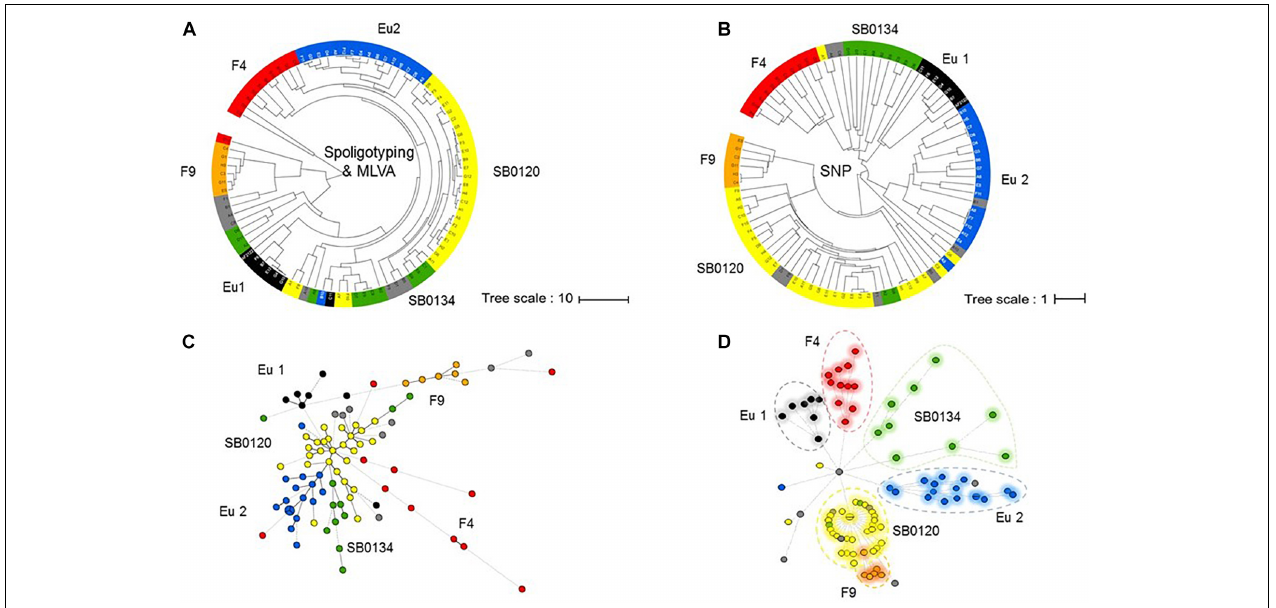
FIGURE 3 | Phylogeny of the French M. bovis field isolates resolved with SNPs. UPGMA phylogenetic tree based on a combination of spoligotyping and MLVA (A) or inferred from the alignment of the pseudosequences of the 9,170 SNPs in the 87 genome (B) . Minimum spanning tree (MST) based on combination of